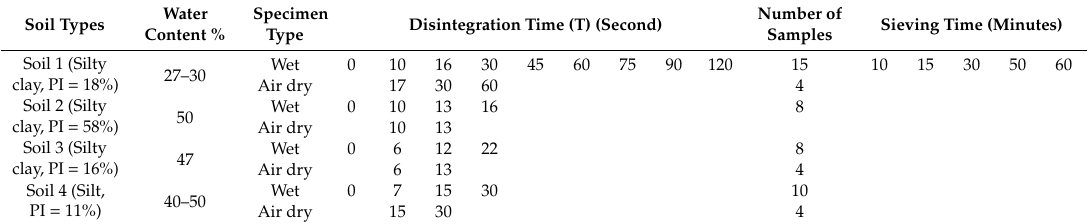
Table 4. The test program for homogenizing and disintegrating the natural soil.